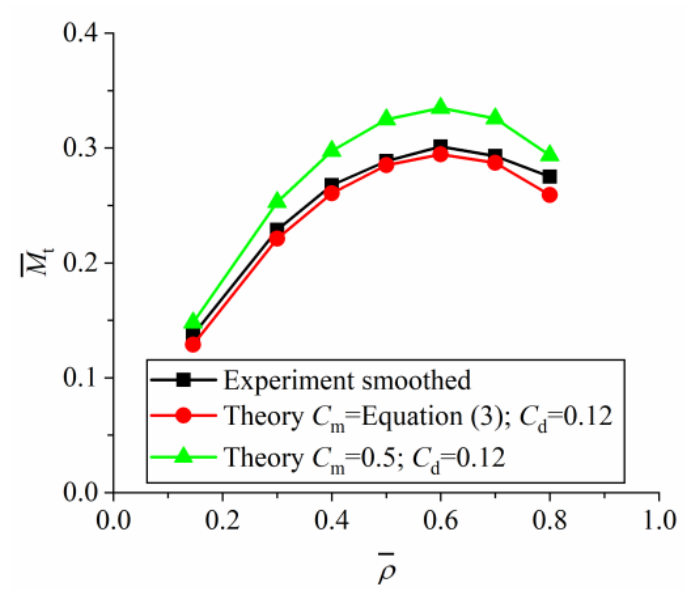
the relative density obtained by three methods with h = 0.089 and